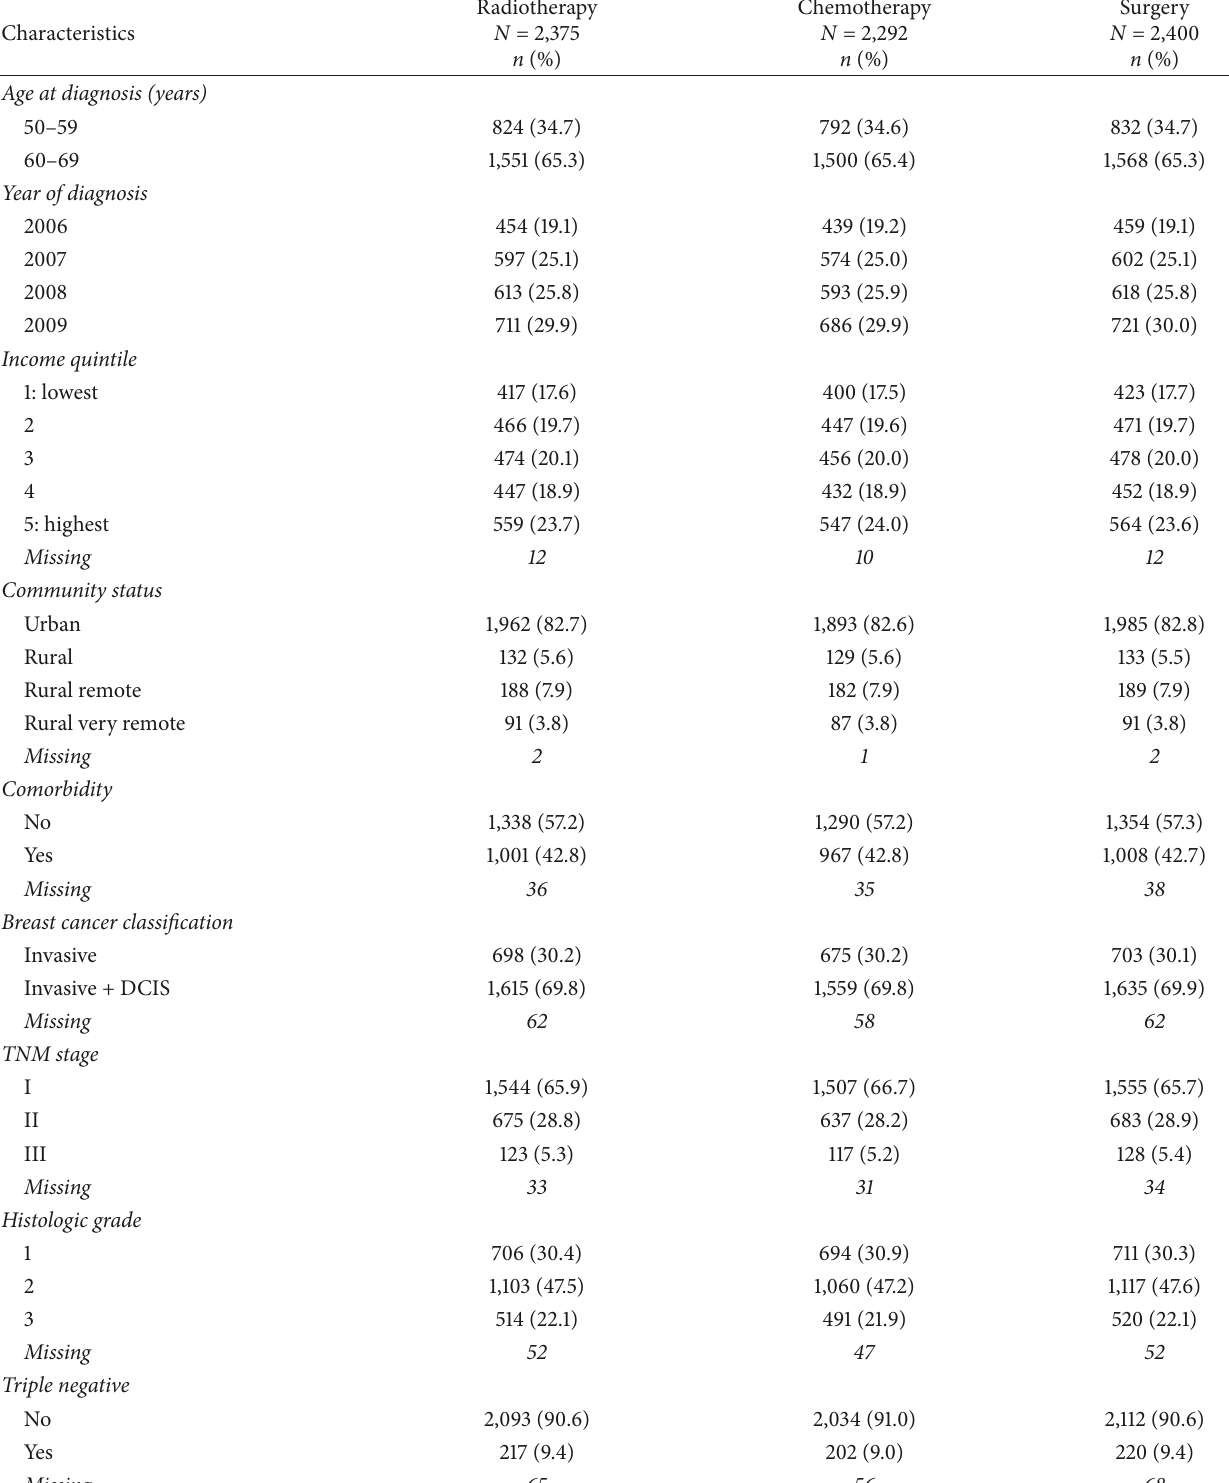
Table 1: Characteristics of eligible women diagnosed with invasive breast cancer through Ontario Breast Screening Program between January 1, 2006, and December 31, 2009, by women with complete radiotherapy, chemotherapy, and surgery